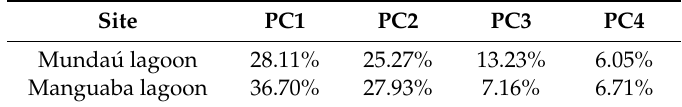
Table 4. Explained variance for the first four rotated principal components for both lagoon in